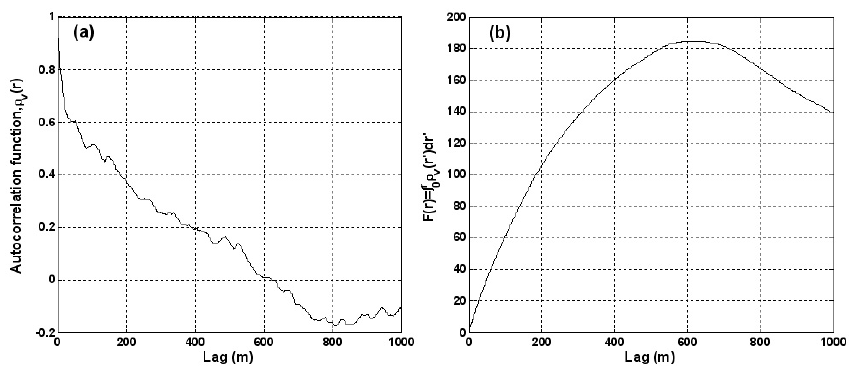
Figure 4. Example (12:00~13:30 18 th August of 2007) of (a) autocorrelation of v-component and Fig. 4. Example (12:00 ∼ 13:30 18 August of 2007) of (a) autocorrelation of v -component wind and (b) corresponding integral of autocor- ρ v (r 0 ) dr 0 as a function of distance lag ( m ), which was derived assuming Taylor’s frozen turbulence hypothesis. Integral relation, F(r) = R r 0 (b) corresponding integral of autocorrelation, ')'()( length scale was taken as F(r) at its first maximum. which was derived assuming Taylor’s frozen turbulence hypothesis. Integral length scale was taken as F(r) at its first maximum.